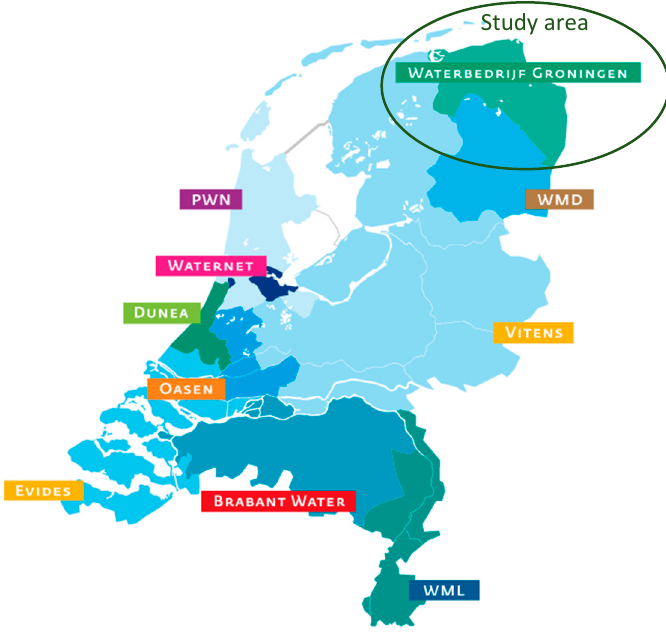
Figure 1. The ten water utilities in the Netherlands. The study area is the Water Utility Groningen (in Dutch: Waterbedrijf Groningen) in the north of the Netherlands. Source: https://www.vewin.nl/sector-in-beeld (accessed on 17 December 2021).